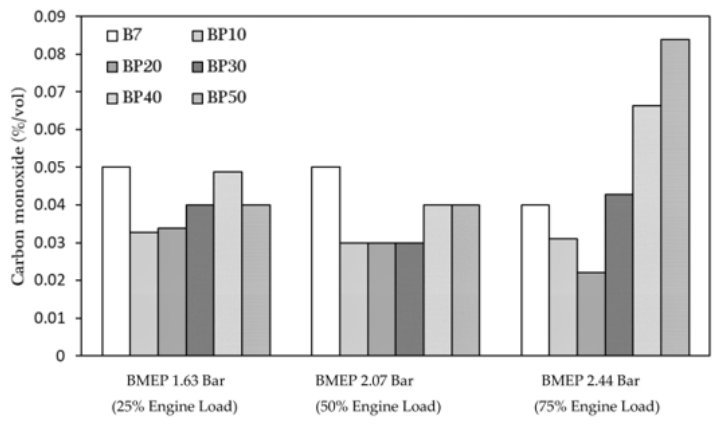
Figure 7. Effects of fuel blends on carbon monoxide emissions (CO).